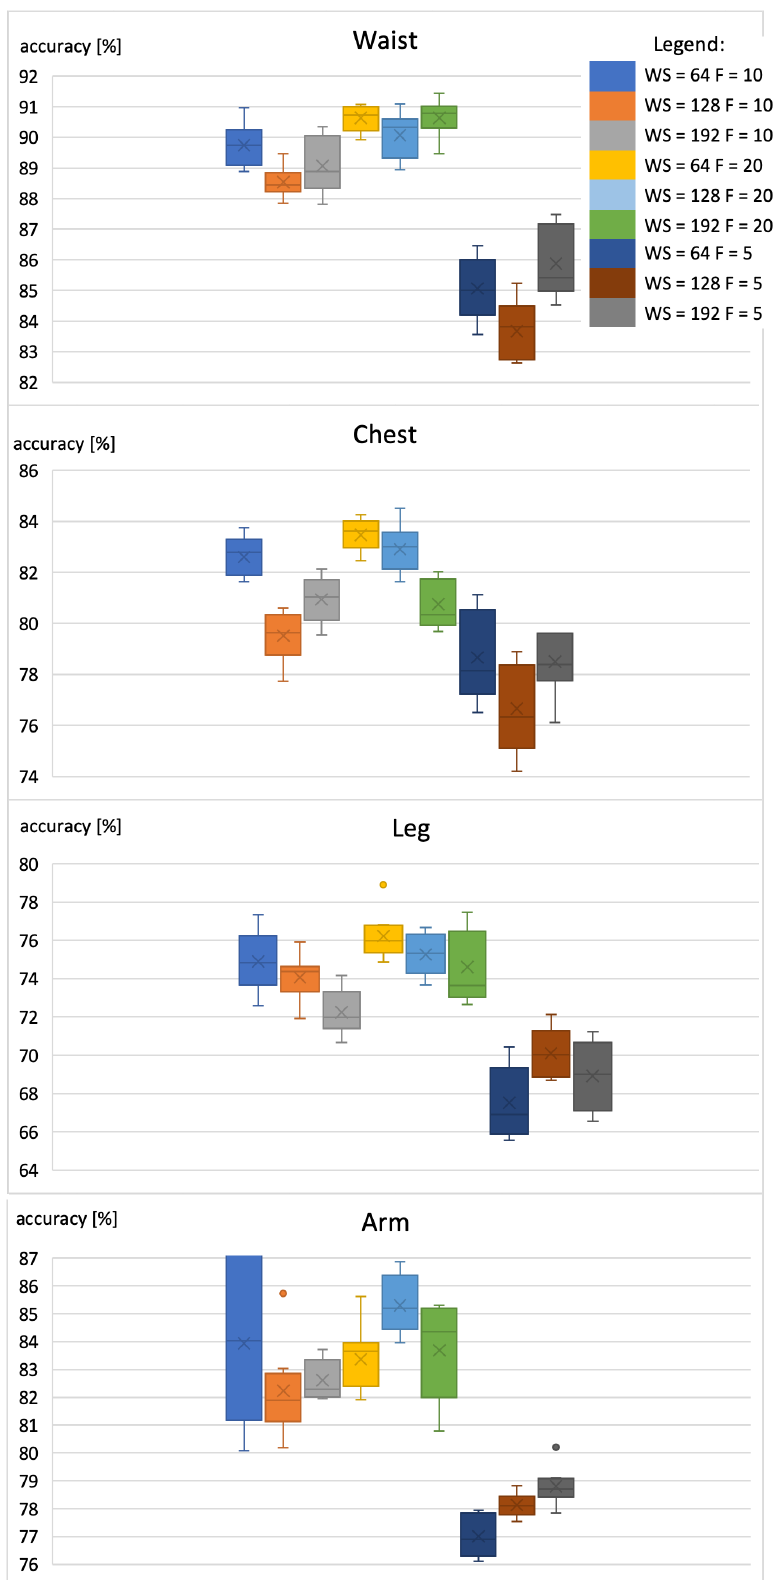
Figure 7. Accuracy of extended activity recognition using the smartphone with the RNN